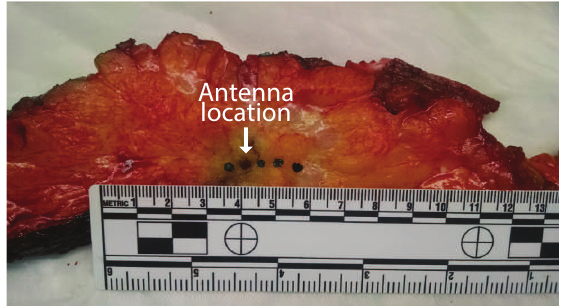
Figure 5. Photograph of a sliced tissue specimen post ablation. The orientation here is the same as the plane of Figure 3. Black ink spots mark the locations of the four dielectric measurements. The second dark circle from the left is the hole where the MWA antenna was